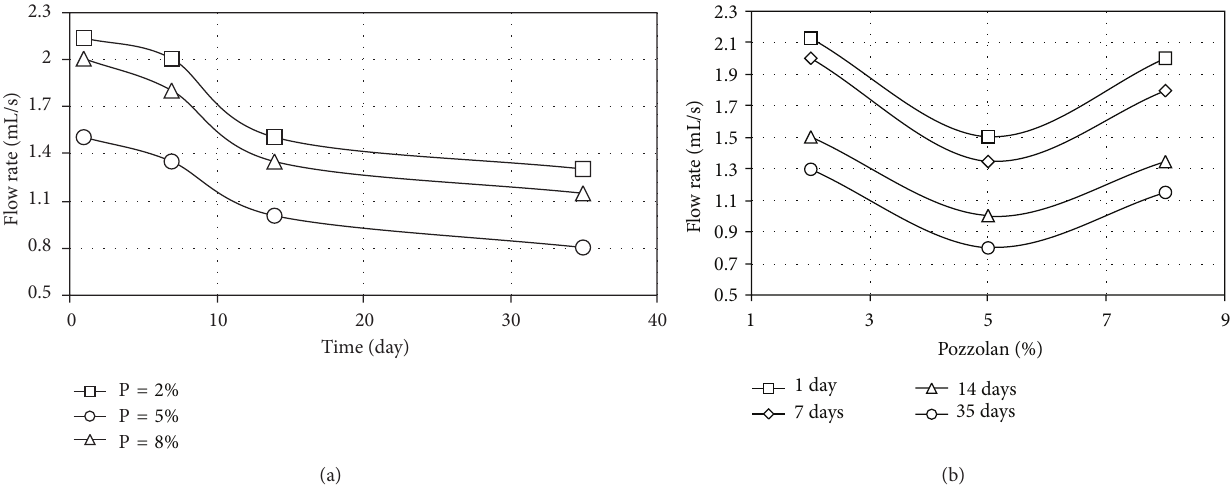
Figure 5: Flow rate for treated samples; (a) of different pozzolan contents plus 1.5% cement content, (b) of different curing times, for different pozzolan contents plus 1.5% cement